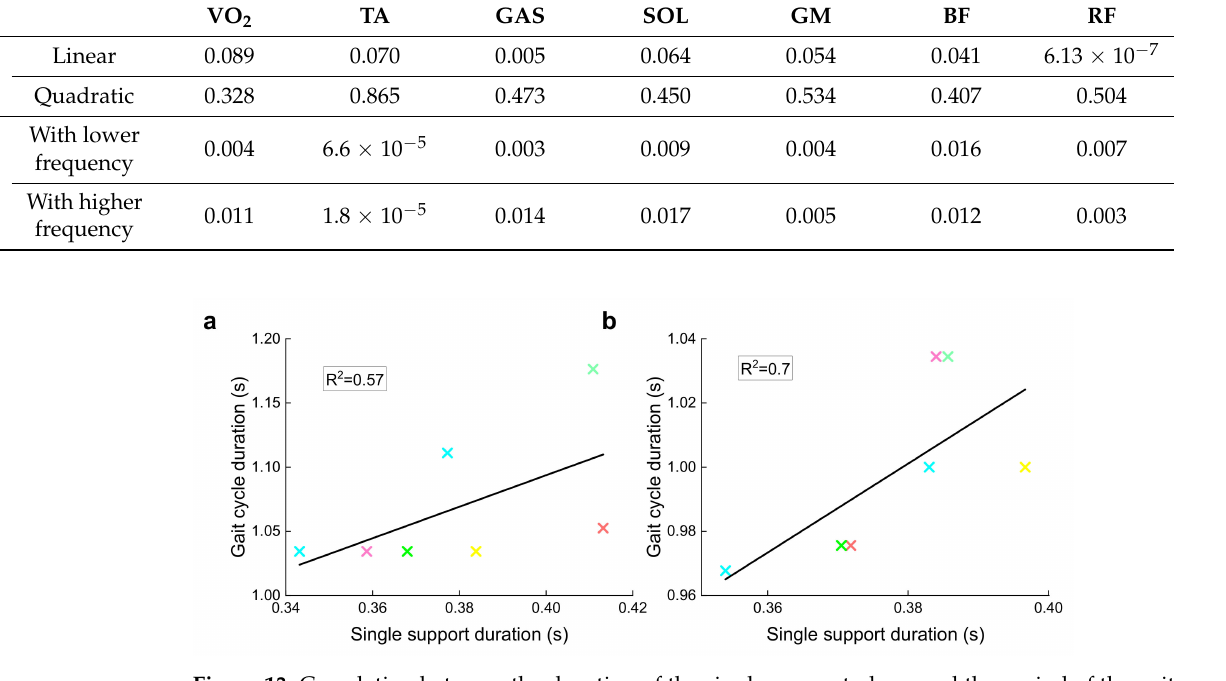
Figure 13. Correlation between the duration of the single support phase and the period of the gait cycle; ( a ) general condition; ( b ) preferred condition. The single support duration was more closely related to the natural frequency of the hybrid spring-mass model under the preferred condition rather than the general